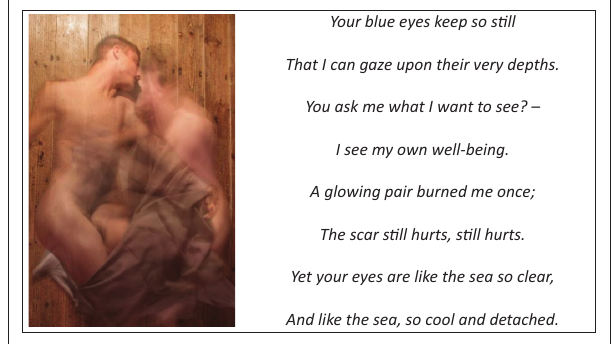
FIGURE 3: Dein blaues Auge : ‘The Floor’.